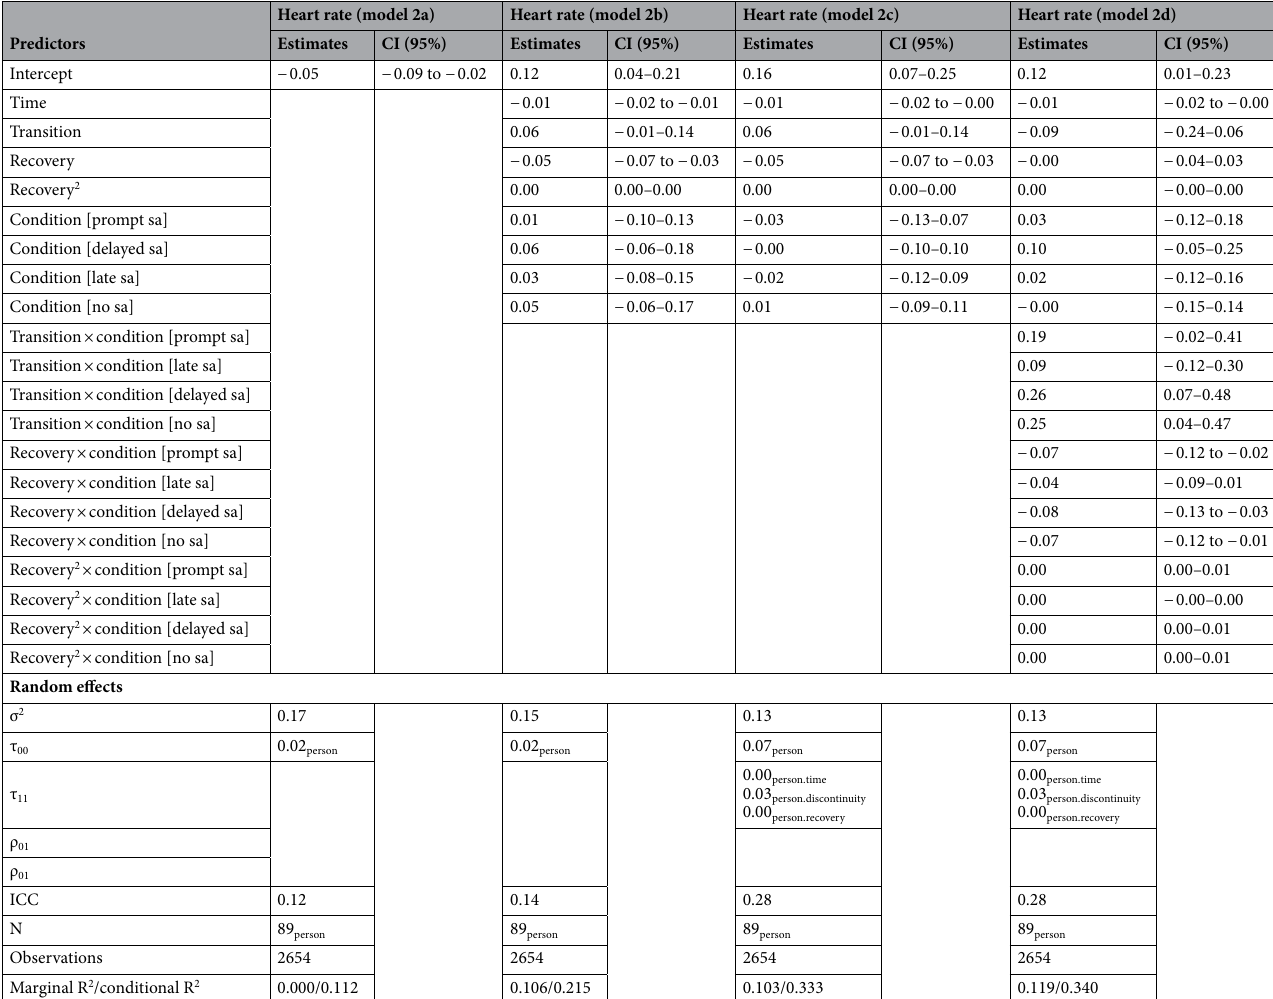
course of the experiment (i.e., the time parameter). The 95% CI of the transition parameter contains zero, sug-